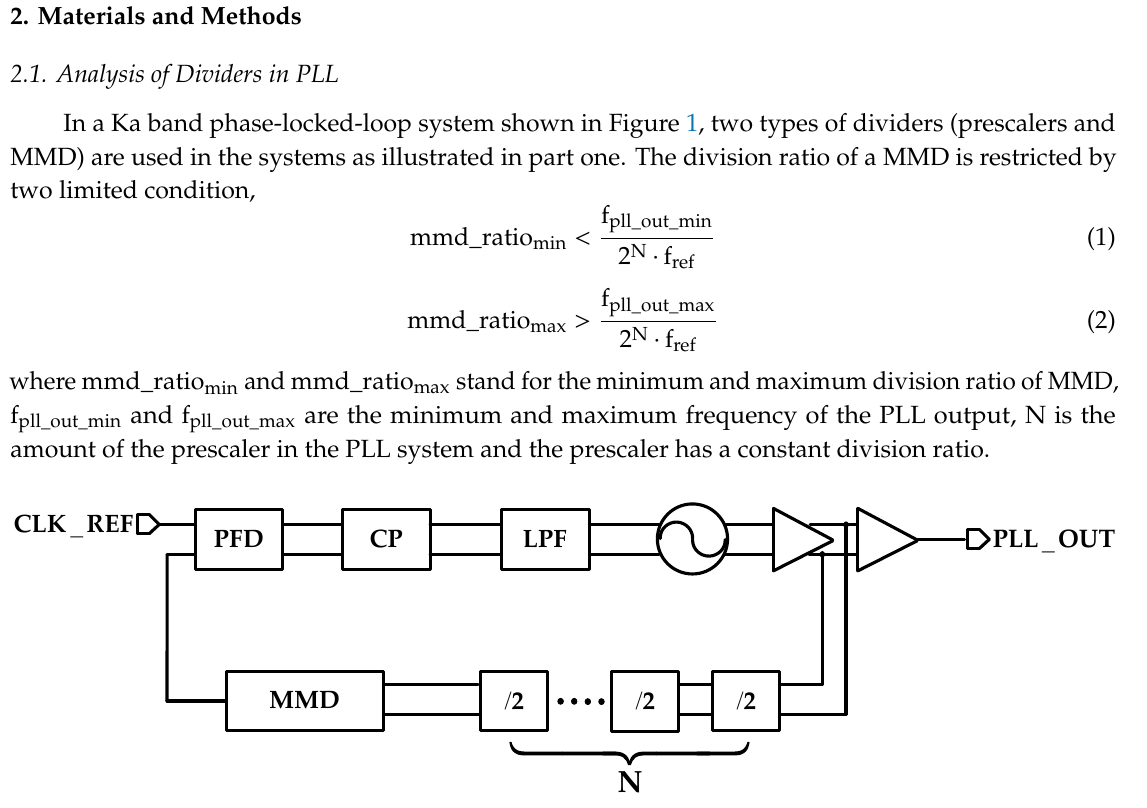
Figure 1. Block diagram of a Ka band PLL.